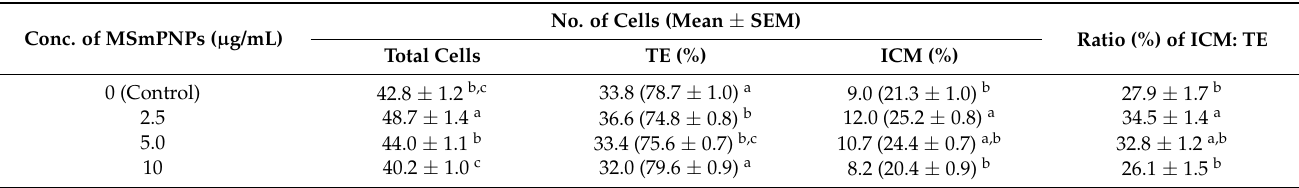
Table 3. The effects of in vitro maturation of porcine oocytes with different concentrations of MSmPNPs on different cell number of in vitro PA blastocysts.